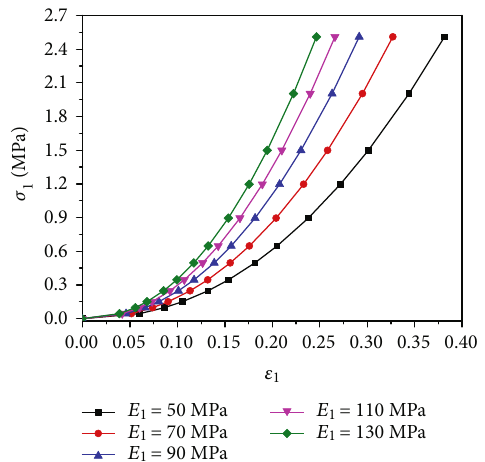
Figure 10: Sensitivity of stress-strain curves to the α in the